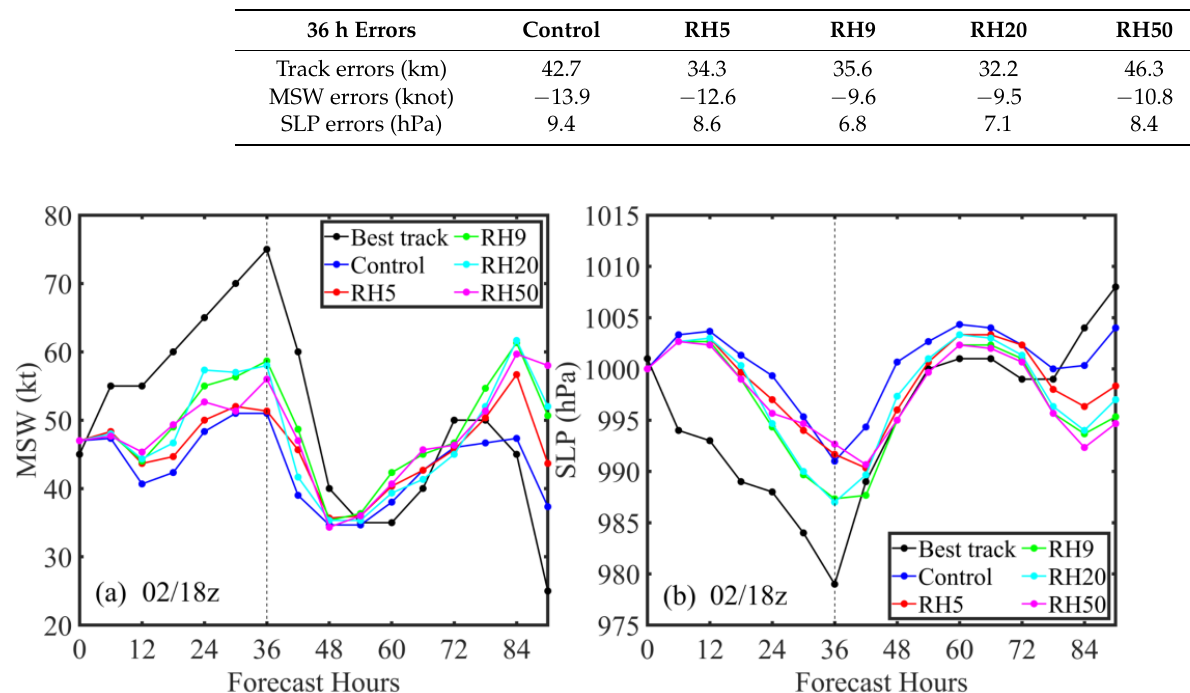
Figure 8. Comparison of the forecast ( a ) MSW and ( b ) SLP for Hurricane Earl for different TDR data thinning experiments against Control and best track at 18 UTC 2 August 2016.